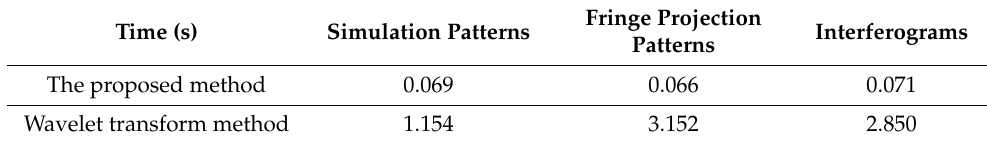
Table 2. Calculated time of the proposed method and wavelet transform method. Time (s) Simulation Patterns